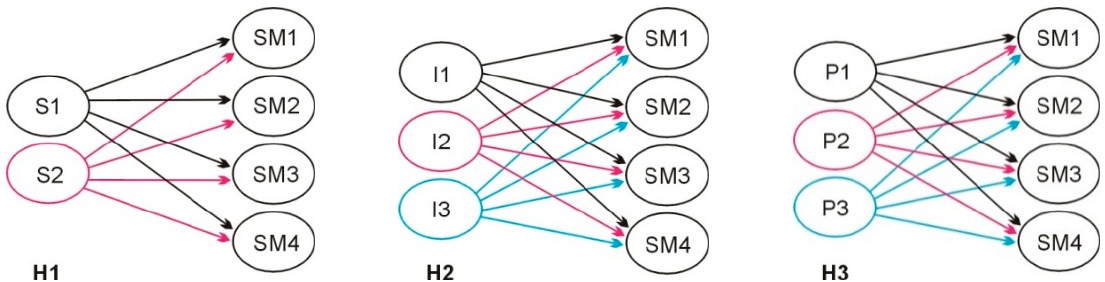
Figure 1. Graphic presentation of the hypotheses. Source: own elaboration.